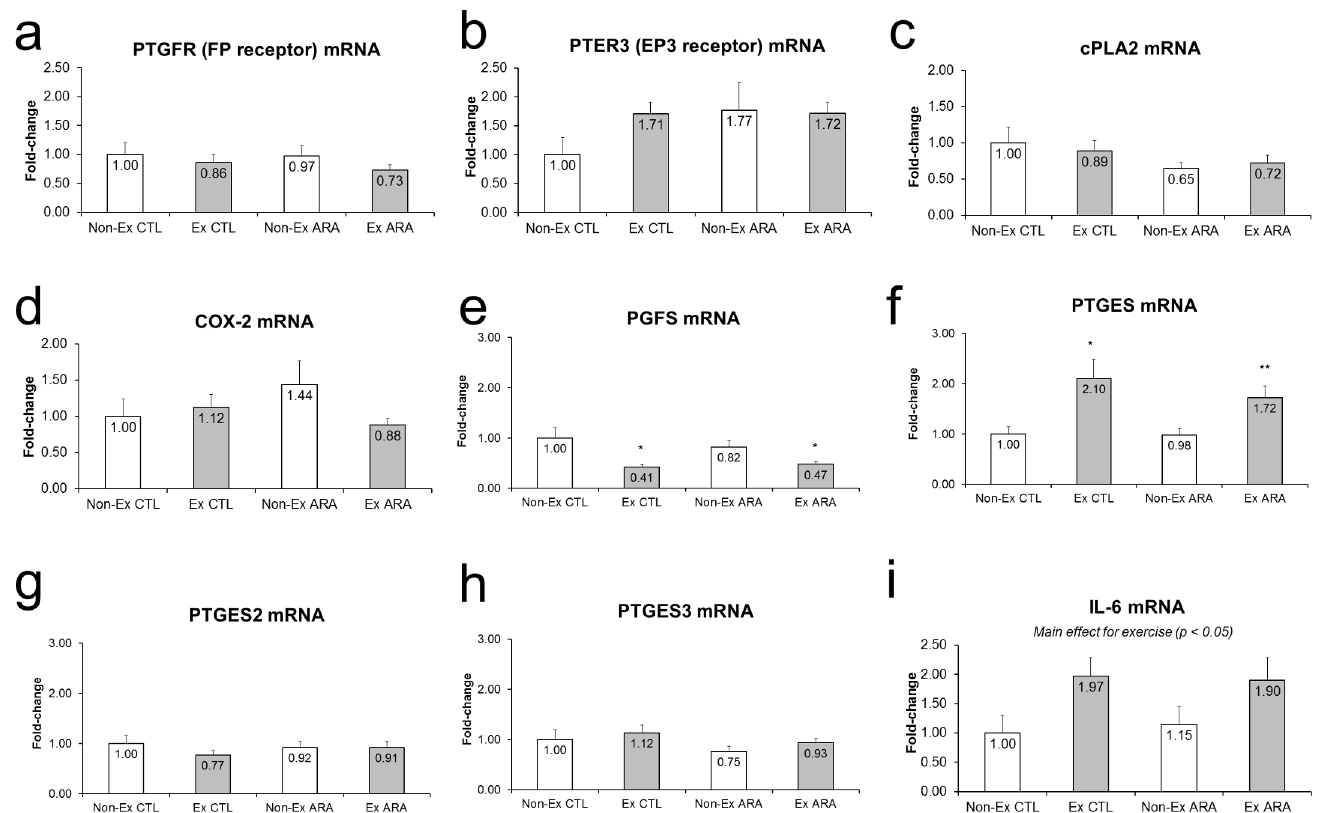
Fig 5. Fold-change values for PTGFR (FP receptor) mRNA expression (a), PTER3 (EP3 receptor) mRNA expression (b), cPLA2 mRNA expression (c), COX-2 mRNA expression (d), PGFS mRNA expression (e), PGTES mRNA expression (f), PGTES2 mRNA expression (g), PGTES3 mRNA expression (h) and IL-6 mRNA expression (i) in non-exercised (open bars) and exercised (closed bars) rodents with (right) and without arachidonic acid